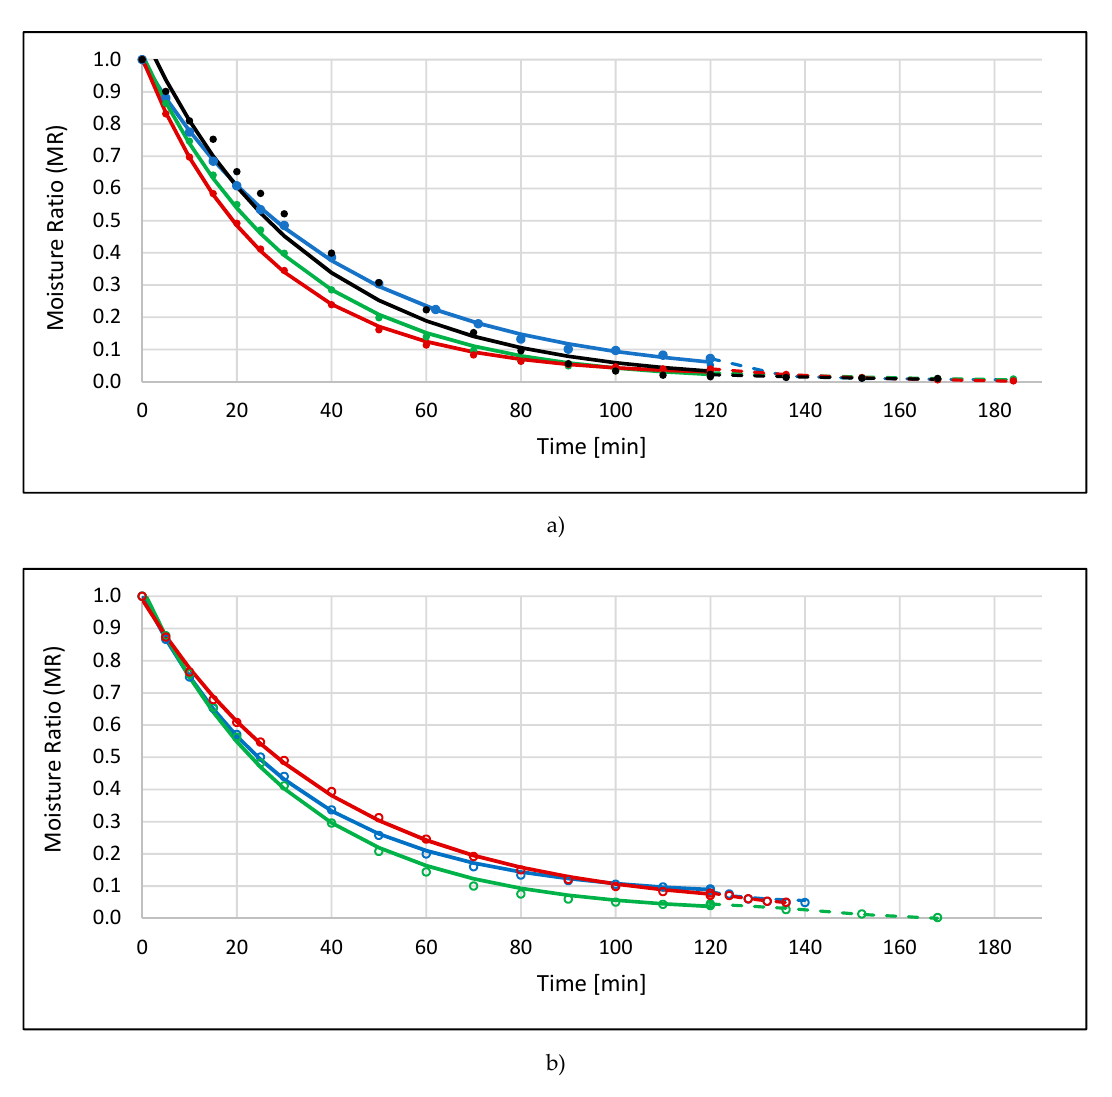
Figure 3. Drying kinetics of apple samples by the combined method (CD/VM), previously osmo-dehydrated in erythritol (blue line), xylitol (green line), sucrose (red line), and without OD (black line), without application of ultrasound ( a ) or with US pre-treatment ( b ). Solid lines are model of convective pre-drying; dashed lines are model of microwave-vacuum finish drying. Parameters of drying models and statistical values of RMSE and R 2 are presented in Table 1.